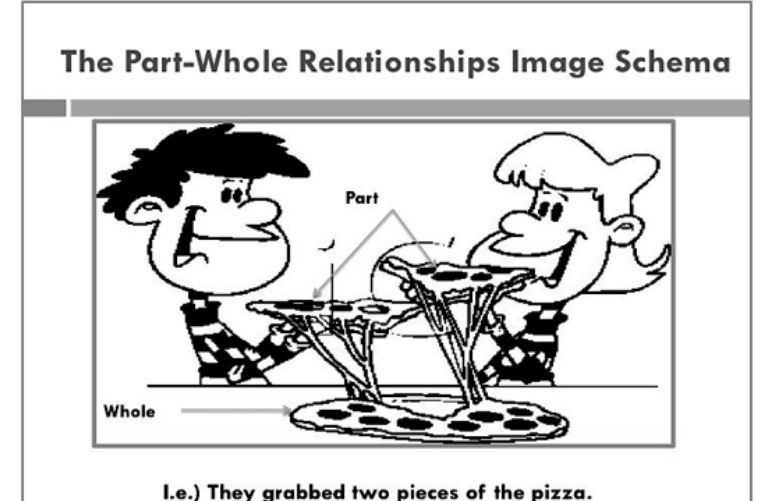
Figure 6 . The PART - WHOLE RELATIONSHIP Image Schema. Figure 6. The part - whole relationship Image